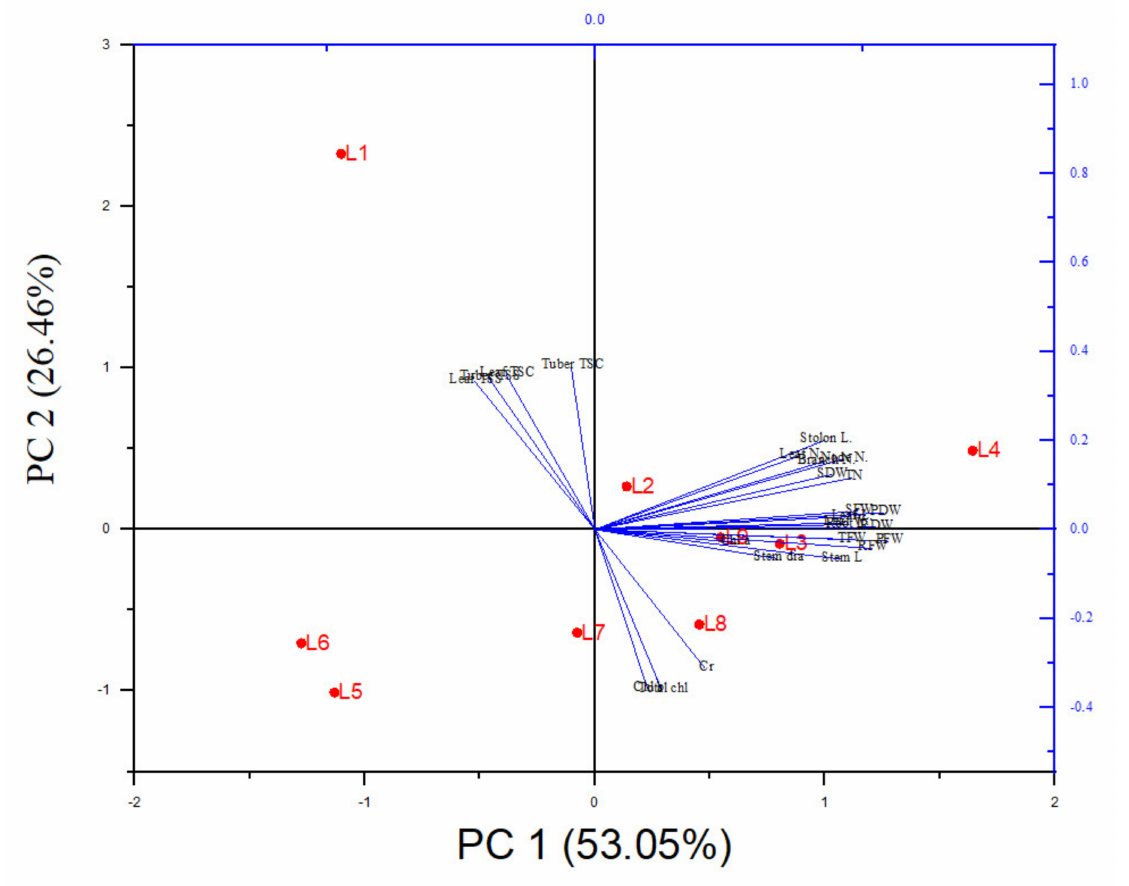
Figure 6. Principal component analysis (PCA) representing patterns and associations between treatments. The lines starting from the central point of the biplots present negative or positive correlations of various light pre-treatment of potato seed tuber seed production in an aeroponic system in PCA, and their proximity determines the degree of correlation with a particular procedure. L1 (natural light), L2 (R:B), L3 (R:B:G), L4 (R:B:FR), L5 (R:B:G:FR), L6 (R:B:G:FR:UV), L7